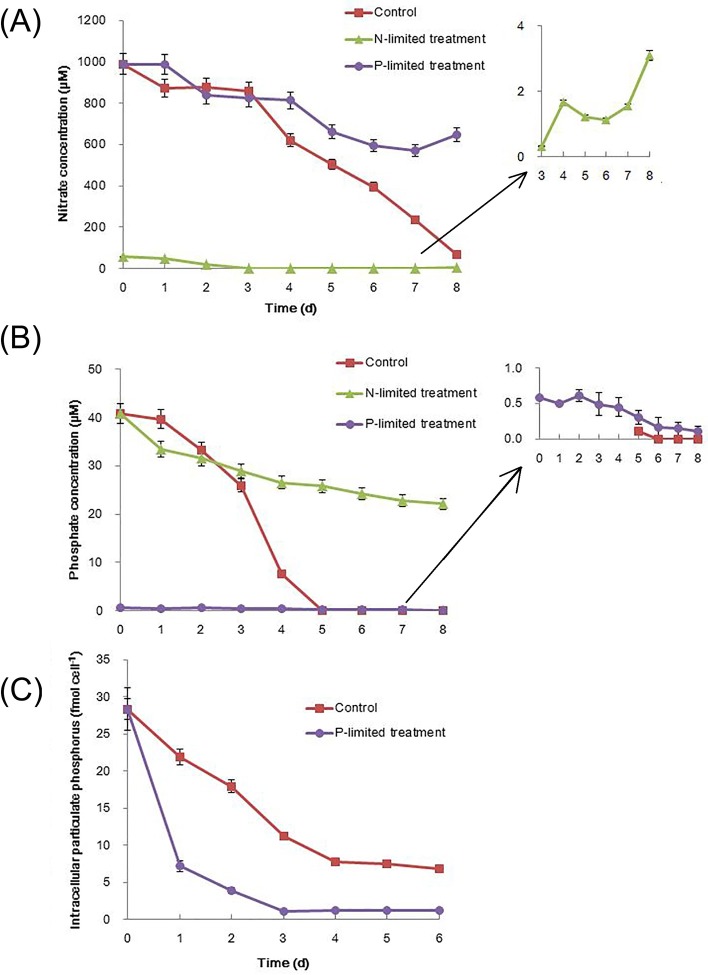
Concentrations of N-NO3− (A) and P-PO43− (B) in media when T. pseudonana cells were cultured under control, N-limited, and P-limited conditions from days 0 to 8. Concentrations of intracellular phosphorus indicated as particulate phosphorus (C) in control and P-limited T. pseudonana cells from days 0 to 6. The error bars represent the standard errors from triplicate measurements (mean±SD).